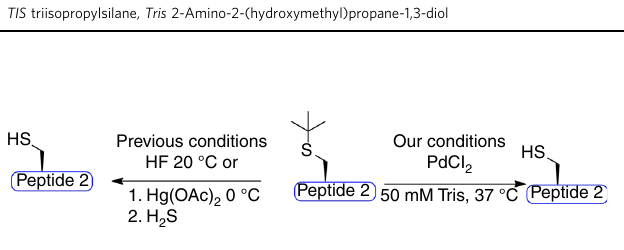
Fig. 2 Removal conditions of Cys( t -butyl). Schematic representation of t -butyl deprotection via PdCl 2 in aqueous buffer compared to the previous conditions